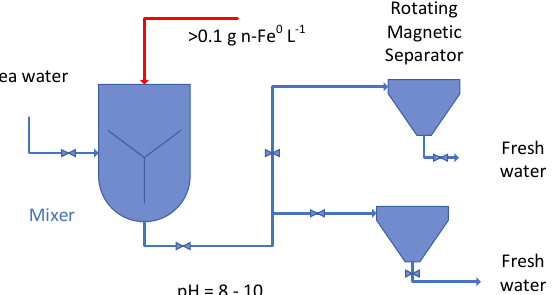
Figure A1. Interpretation of the ZVI desalinator described in patent ES2598032B1, showing how it may be operated to allow for a continuous water feed (of seawater or saline groundwater) producing fresh water (potable) quality irrigation water with a batch removal of n-Fe 0 + NaCl. This reactor requires a Desalination Pattern 1 (Appendix B) outcome to operate. A stirred reactor is used to maximize particle